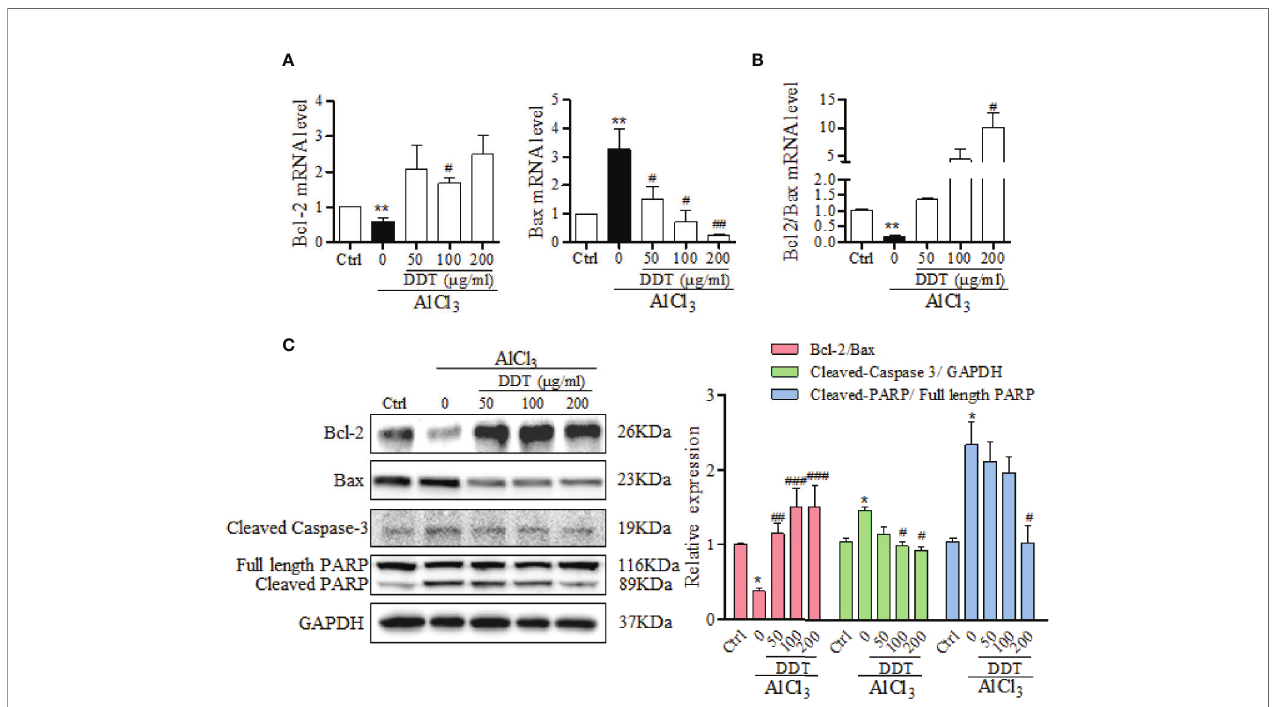
FIGURE 4 | DDT inhibits apoptotic-related signaling pathway induced by AlCl 3 in PC12 cells. (A) The mRNA levels of Bcl-2 and Bax in AlCl 3 -induced PC12 cells treated with different concentrations of DDT for 48 h were detected by qPCR analysis. b -actin was an internal control. (B) The ratio of Bcl-2/Bax at the mRNA level is shown. (C) The levels of Bcl-2, Bax, cleaved caspase-3, and cleaved PARP in PC12 cells after 48 h of AlCl 3 incubation and DDT treatment were detected by western blot analysis. The relative expression of each protein was quanti fi ed based on normalization to GAPDH level and is shown on the right. Values are means ± standard derivation from three independent experiments. Ctrl: control group. * p < 0.05, ** p < 0.001 vs. control group; # p < 0.05, ## p < 0.01 , ###p < 0.001 vs.